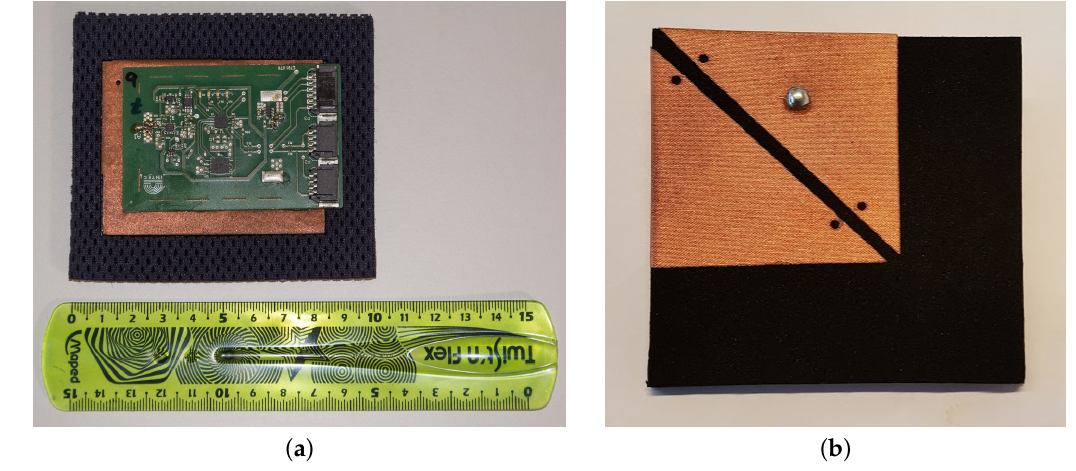
Figure 2. Example of an exposure meter node: ( a ) Back side of the exposure meter node, showing the printed circuit board (PCB) and the ground plane of the antenna under the PCB; ( b ) Front side of the exposure meter node showing the fabricated antenna (resonators) glued to the